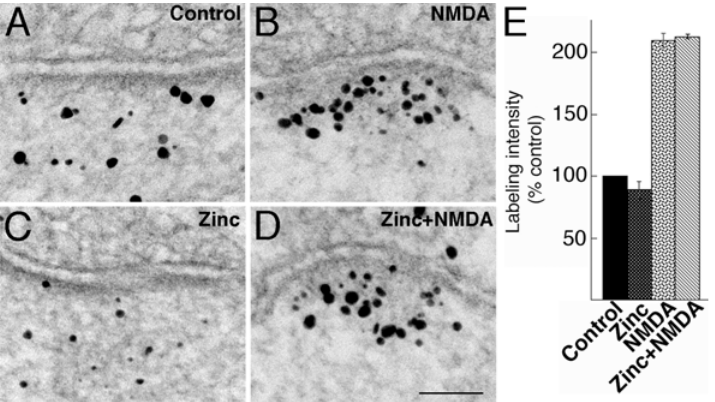
Fig 7. (A-D) Electron micrographs of asymmetric synapses labeled for CaMKII. Experimental conditions were as described in Fig 5. Label for CaMKII was dispersed in the postsynaptic cytoplasm under basal control conditions (A) or after zinc incubation (C), and the curvature of the PSD was typically flat. After NMDA (B) or zinc+NMDA (D) treatment, label for CaMKII was accumulated at the PSD, and the curvature of PSD was typically arched into the presynaptic terminal. Scale bar = 0.1 μ m. (E) Bar graphs represent combined data from S6 Table. Zinc has no effect on the labeling intensity of CaMKII at the PSD either under basal conditions or upon treatment with NMDA.